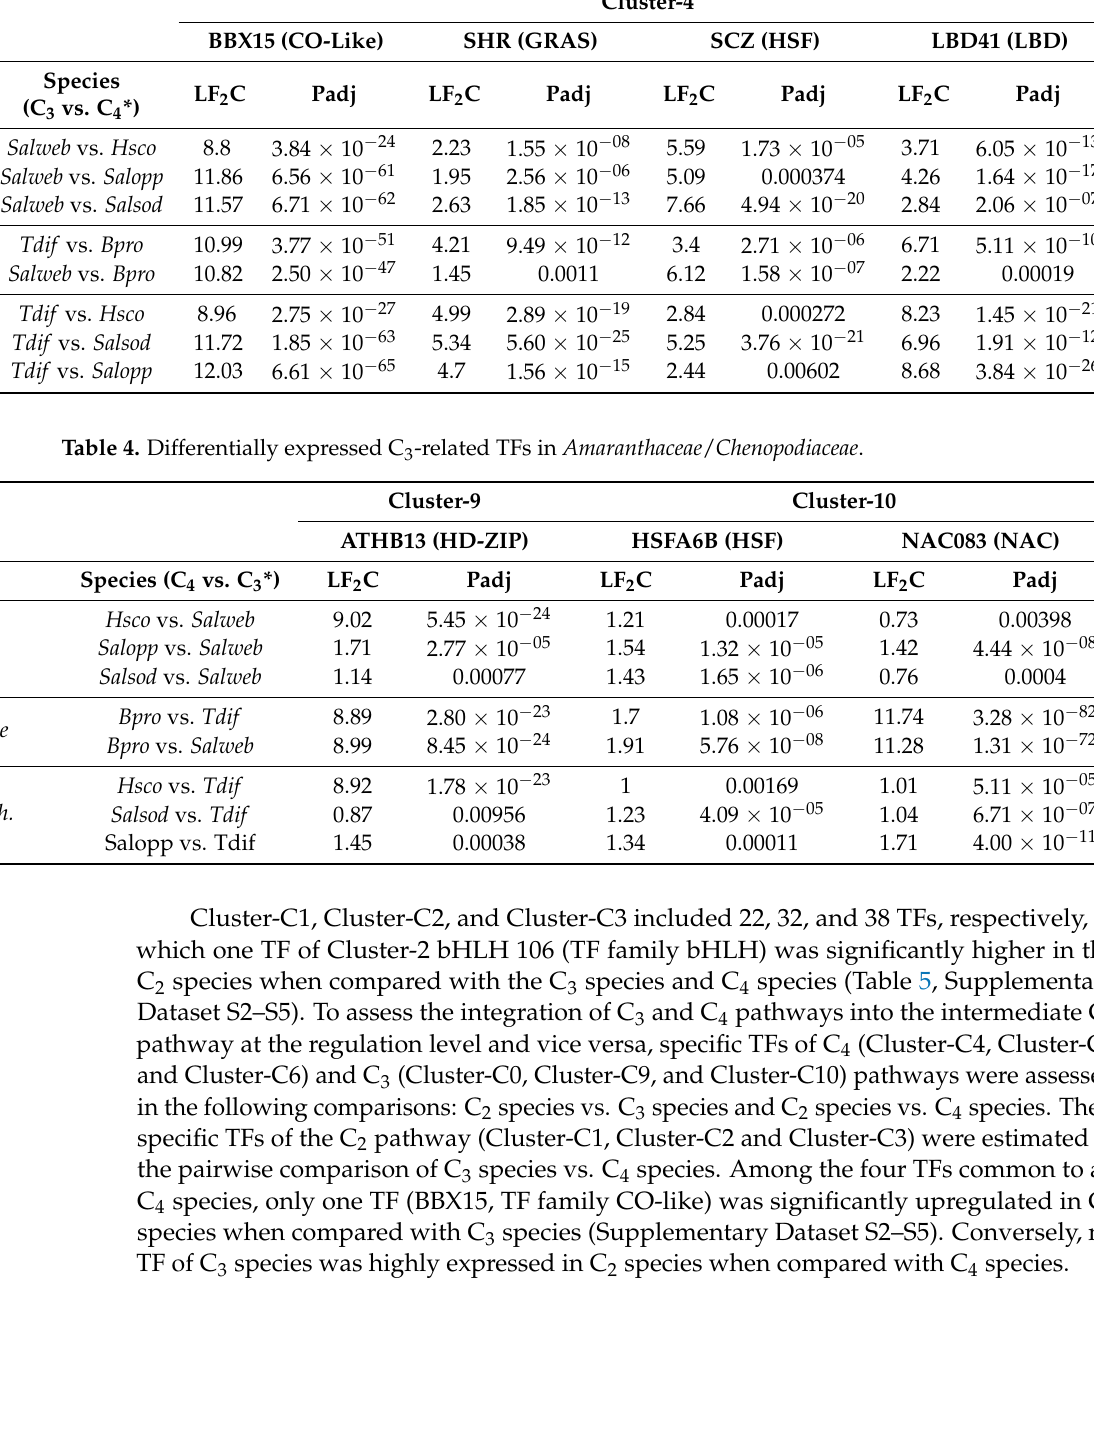
Table 3. Differentially expressed C 4 -related TFs in Amaranthaceae / Chenopodiaceae . BBX15 (CO-Like)